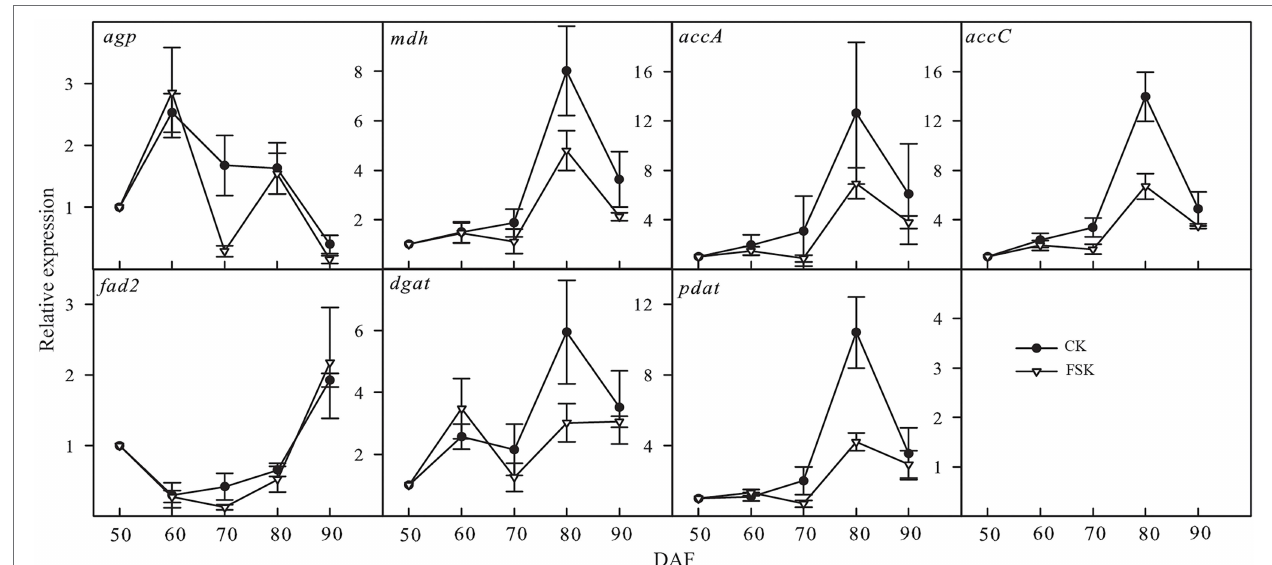
FIGURE 5 | Temporal expression patterns of genes involved in oil accumulation in the FSK and CK groups during Styrax tonkinensis kernel development from 50 to 90 DAF. Panels show relative expression levels determined by qRT-PCR of seven key genes (50 DAF as the